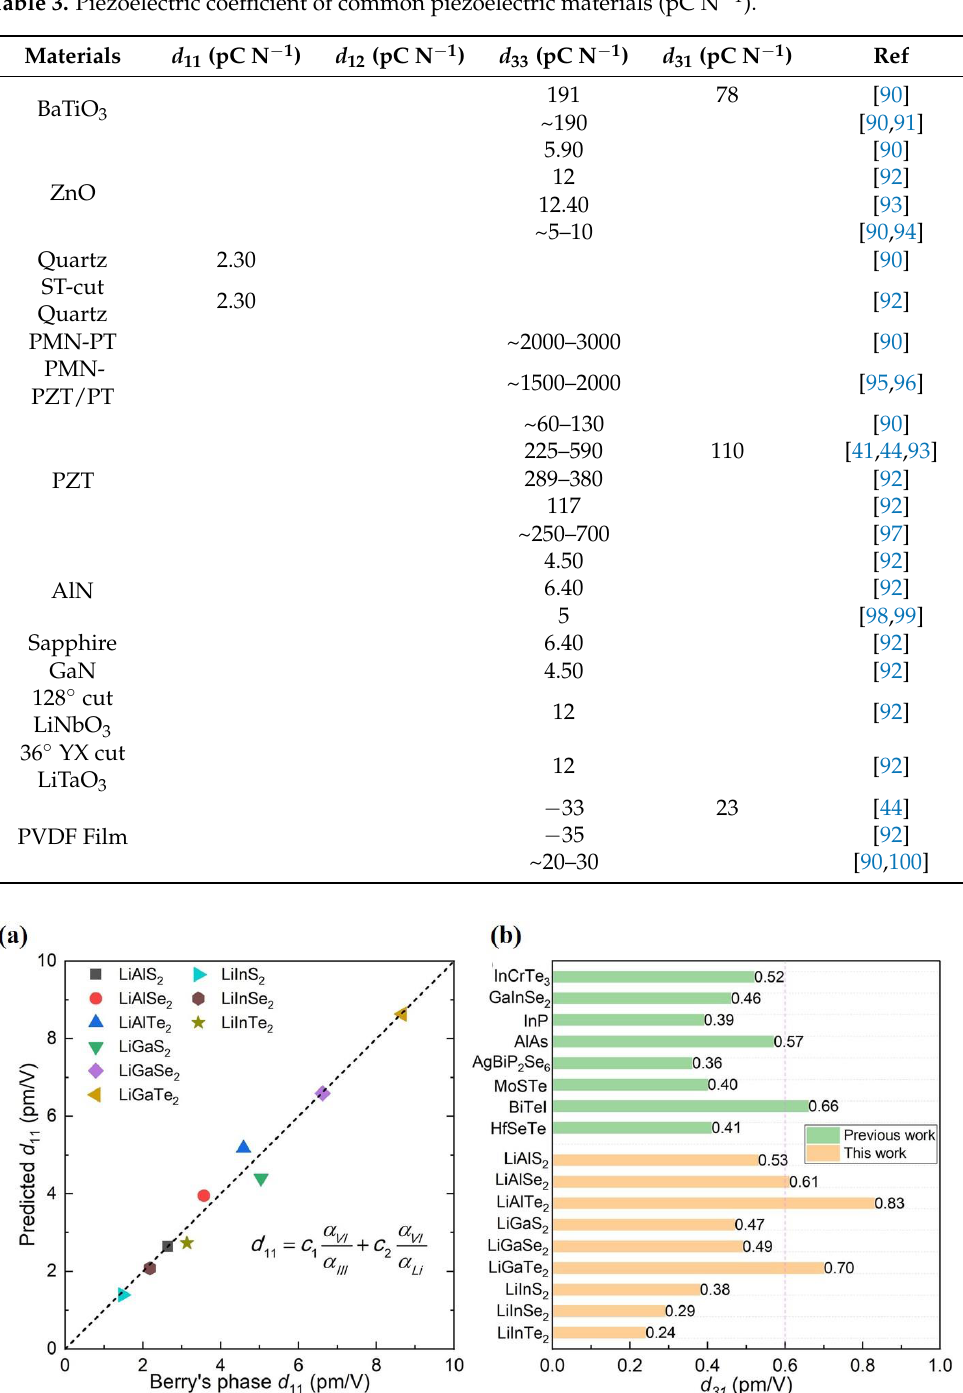
Figure 15. ( a ) Relationship between piezoelectric coefficient d 11 and polarizability of LiMX 2 mono- layer [87]. Reprinted from [87], copyright 2021, with permission from Elsevier. ( b ) Comparison